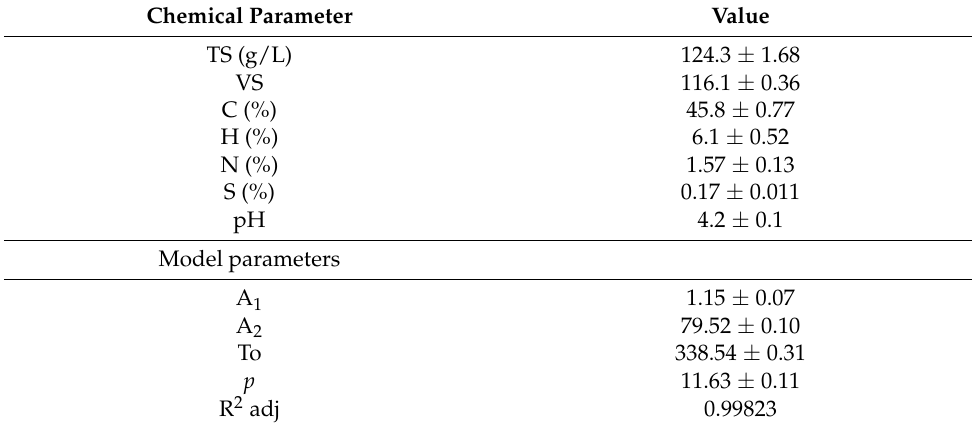
Table 3. Characteristics of fourth-range waste and model parameters obtained for describing the conversion ( α ) behavior under thermal